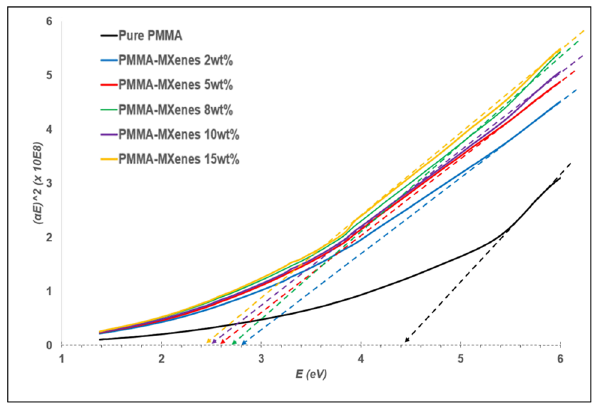
Figure 9: Tauc plot for all samples as a function of photon energy ( E ) .